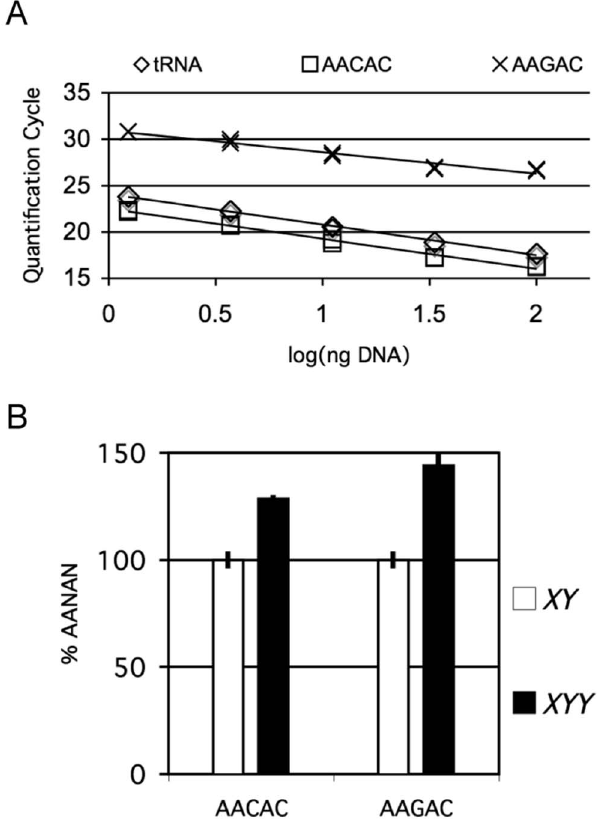
Figure 2. Experimental validation of qPCR assay to measure satellite copy number. ( A ) Quantification cycle (C q ) of duplicate qPCR reactions plotted as a function of template DNA per reaction. X- axis represents log 10 of an approximately 100-fold dilution series. ( B ) Quantification of satellite copy number in X / Y males and to X / Y / Y males, relative to X / Y (defined as 100%). Error bars represent standard error of the mean (S.E.M.) derived from triplicate reactions.